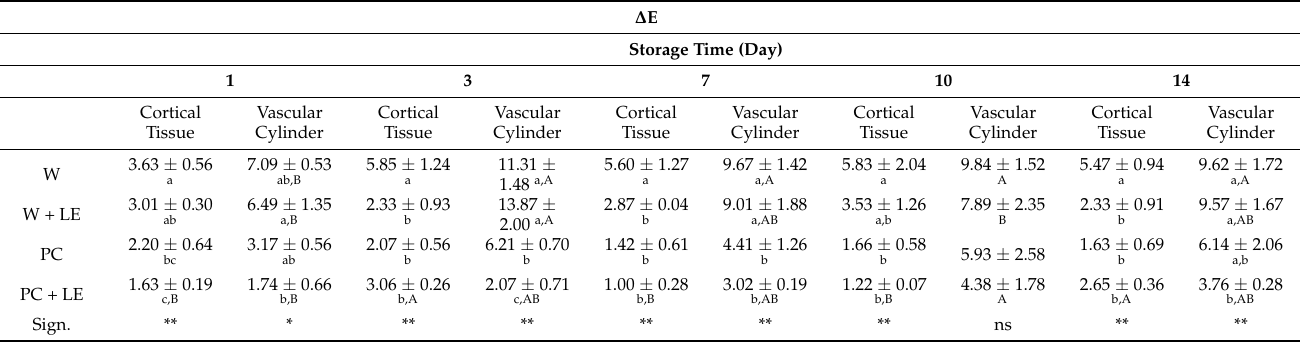
Table 2. Total colour difference ( ∆ E) of uncoated and coated fresh-cut carrots throughout 14 days of storage (4 ◦ C). ∆ E Storage Time (Day) 3 7 10 14 Cortical Vascular Cortical Vascular Cortical Vascular Cortical Vascular Cortical Vascular Tissue Cylinder Tissue Cylinder Tissue Cylinder Tissue Cylinder Tissue